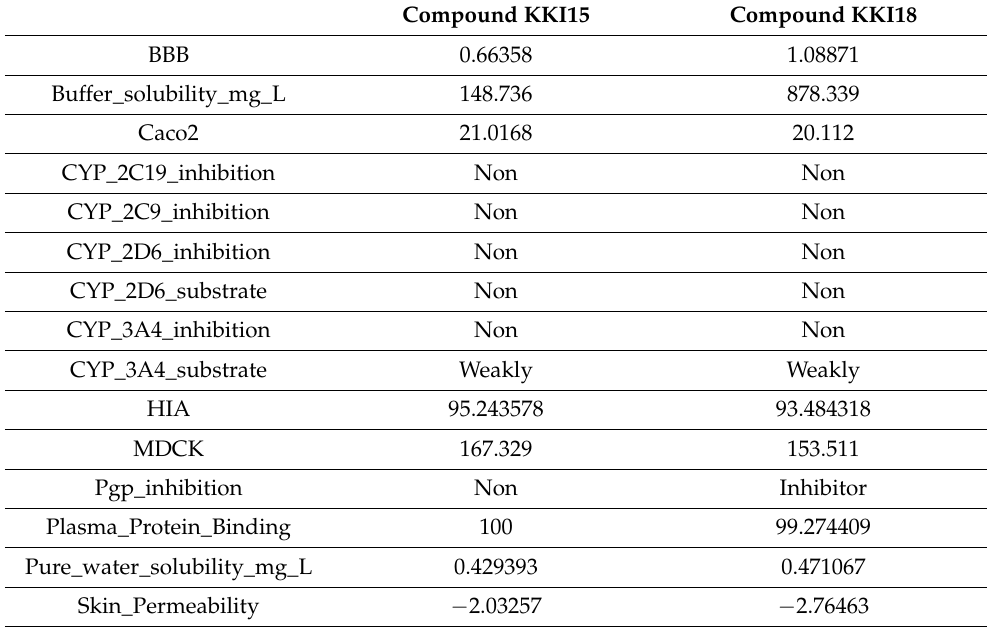
Table 10. The ADME results of KKI15 and KKI18 according to